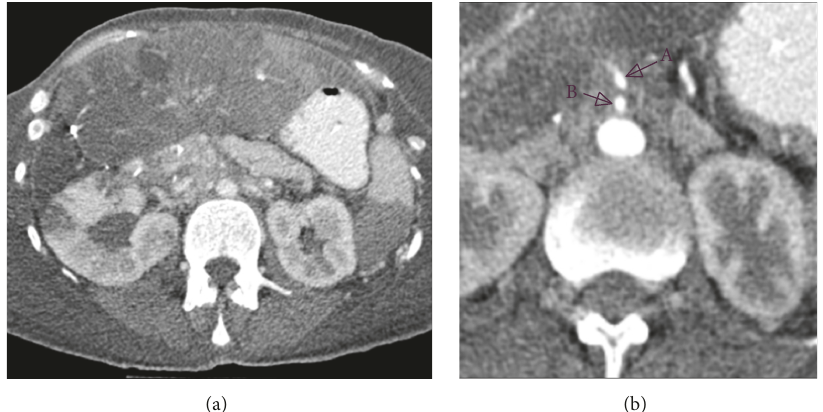
Figure 2: Abdominal CT-scan. (a) Centralized perfusion with constricted peripheral intestinal arteries. (b) Reduced diameters of abdominal arteries. (A) Truncus coeliacus: 3mm. (B) A. mesenterica sup.: 3 mm; aorta 15 mm.